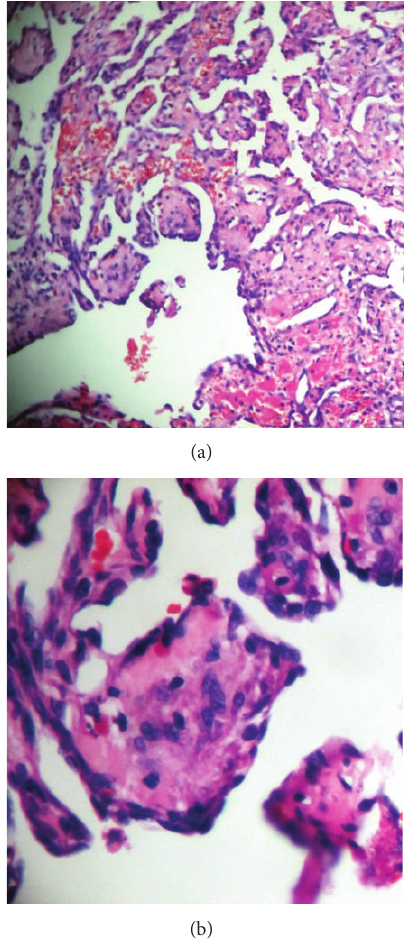
Figure 11: (a) Low power view of intravascular papillary processes within the lumen of dilated vein (H&E, original magnification × 40). (b) High power view showing papillary processes lined by benign endothelial cells (H&E, original magnification ×